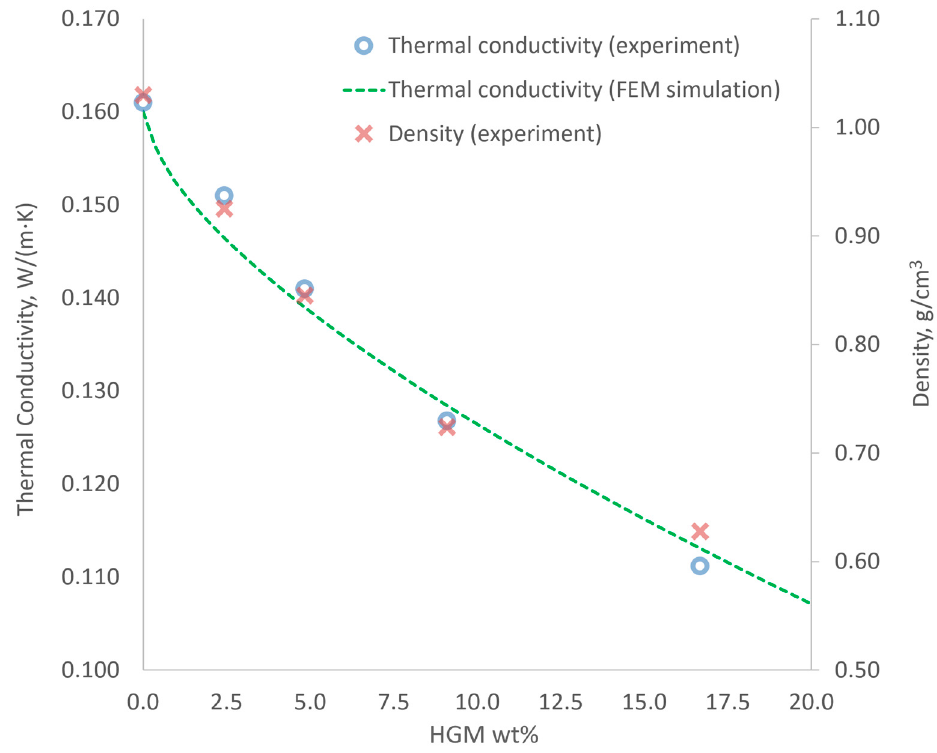
Figure 4. The dependence of thermal conductivity and density of PDMS-HGMs composite on HGMs content.